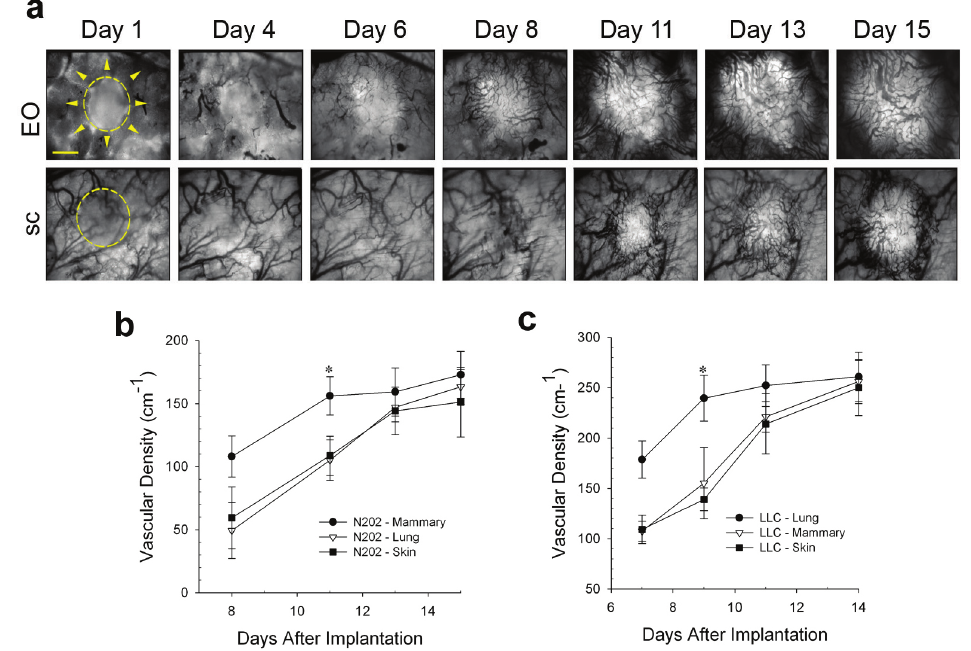
Figure 3. Effect of tissue co-engraftment on tumor vascular development. ( a ) Phase images of N202 tumor spheroids expressing H2B- GFP that were implanted directly onto the dorsal skin (sc) or with donor mammary tissue (EO) as indicated and monitored by IVM at the indicate times after implantation. N202 ( b ) and LLC ( c ) tumor vascular densities were measured at the indicated times (see Methods). Scale bar = 10 μm. Mean +/- SD are shown. * = p<0.05. n = 3–4 mice for all